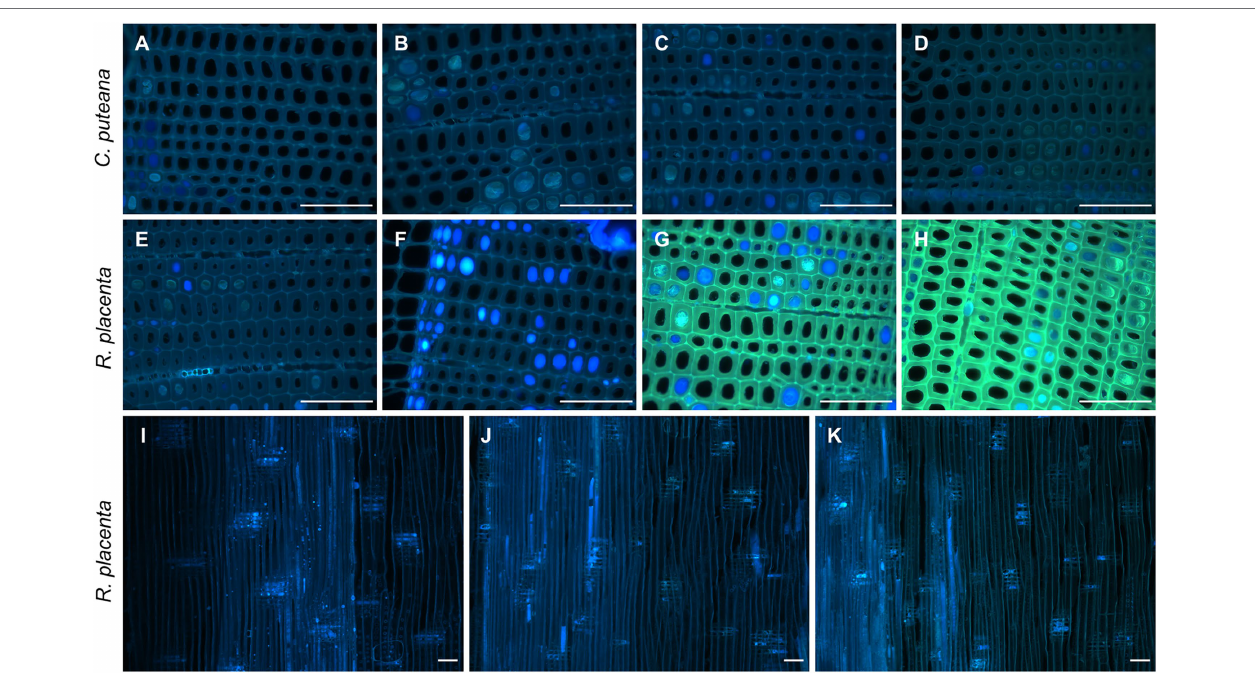
FIGURE 4 | Fluorescence images (ex: 330–385 nm, em: 420-nm) from decayed heartwood blocks. Transverse sections from C. puteana -exposed wood at sample positions 1 (A) , 5 (B) , 6 (C) , and 7 (D) , transverse sections from R. placenta -exposed wood at positions 1 (E) , 3 (F) , 4 (G) , and 5 (H) , and radial sections from R. placenta -exposed wood at positions 1 (I) , 6 (J) , and 7 (K) . Images (A–H) were collected after 30 s of UV exposure in the microscope (330–385 nm), using the same acquisition settings for every image. Images (I–K) were collected without additional UV exposure. Scale bars are 0.1 mm.